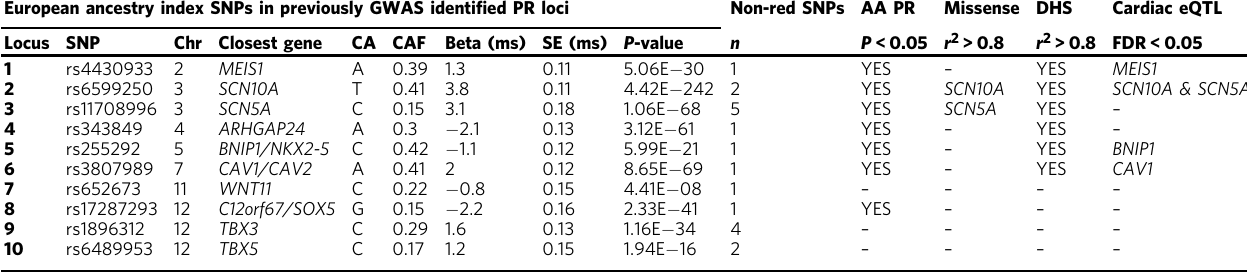
Table 1 Description of PR loci previously identi fi ed by GWAS among those of European descent European ancestry index SNPs in previously GWAS identi fi ed PR loci